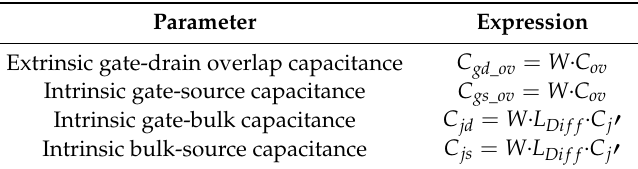
Table 2. MOS extrinsic capacitance expressions.